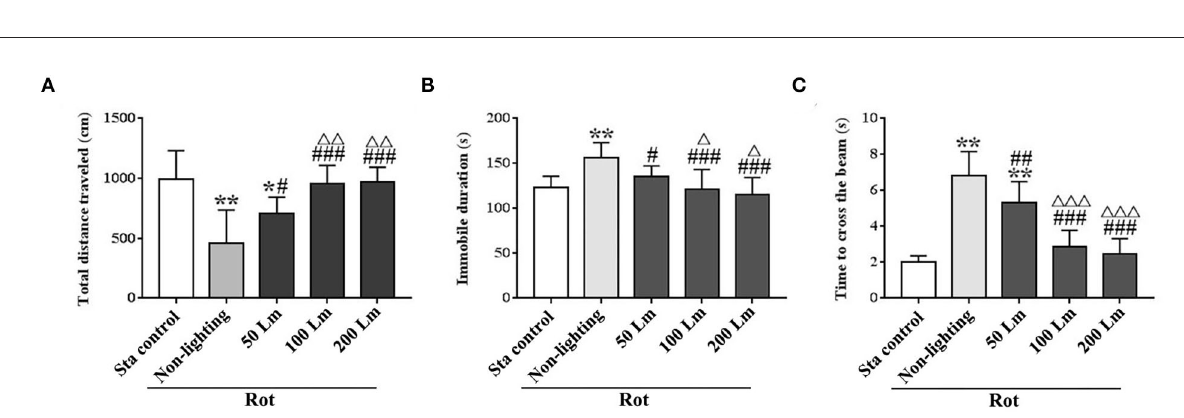
FIGURE5 Effects of synchronized stroboscopic light (6 cycle/min, warm light) with different peak intensities (50, 100, and 200Lm) on hypoactivity and balance disturbance induced by rotation in rats. Spontaneous locomotion activity was characterized by total distance traveled (A) and immobile duration (B) , while balance performance was characterized by the time to cross the elevated balance beam (C) . Rot, rotation stimulation; Sta, static control treatment. Data are expressed as mean ± S.E. * P < 0.05, ** P < 0.001 vs. the Sta control group; # P < 0.05, ## P < 0.01, ### P < 0.001 vs. the Rot non-lighting group; 1 P < 0.05, 11 P < 0.01, 111 P < 0.001 vs. the 50Lm Rot